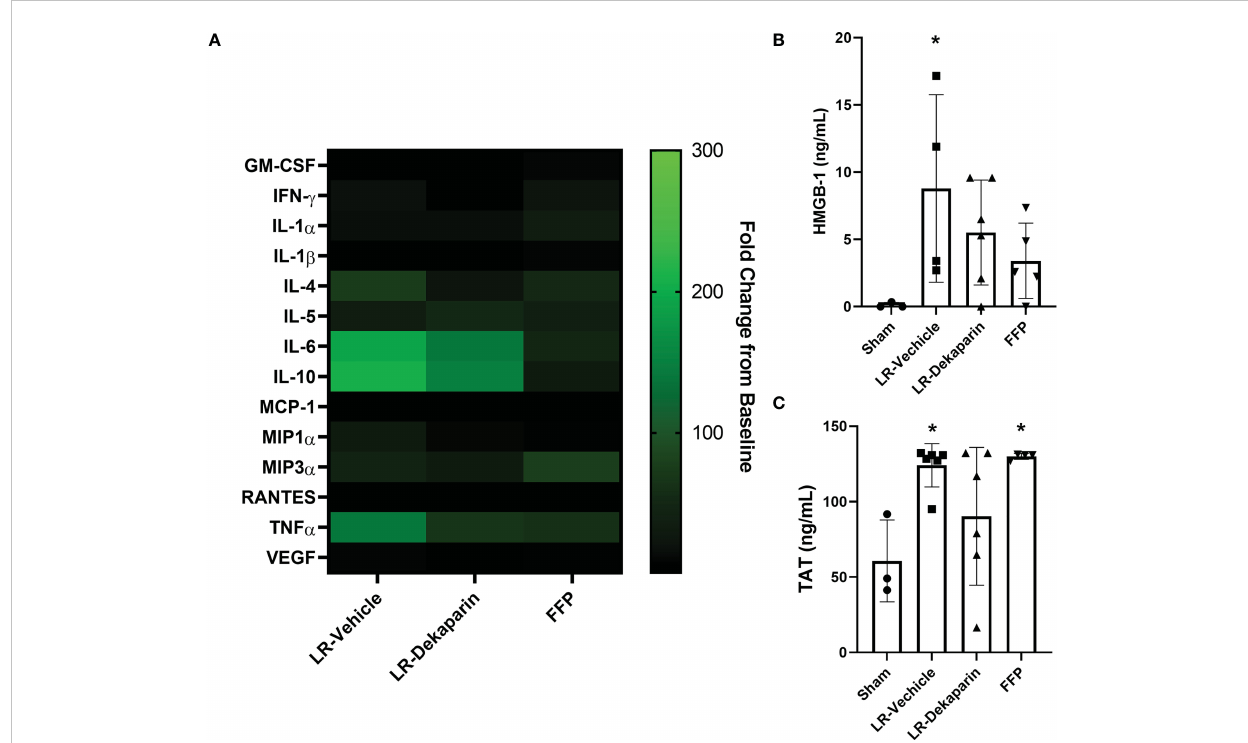
FIGURE 7 Dekaparin treatment decreases plasma levels of thromboin fl ammatory mediators after T/HS. (A) Cytokine and chemokines were quanti fi ed in the baseline and 3HR plasma sample by Bio-Plex Pro Rat Cytokine 23-Plex Assay. Analysis was restricted to N=4 per group due to assay cost. Markers that were undetectable were not included in the analysis. Data at 3HR were normalized to baseline values and expressed fold change over baseline in a heat map. (B) High mobility group box-1 (HMGB-1) and (C) thrombin-antithrombin (TAT) complex levels were measured in 3HR plasma samples by enzyme-linked immunosorbent assay (ELISA). For HMGB-1 ELISA: N=3 Sham, N=4 LR-vehicle, N=6 LR-Dekaparin, N=5 Sham. For TAT ELISA: N=3 Sham, N=6 LR-vehicle, N=6 LR-Dekaparin, N=4 FFP. Data are expressed as mean with standard deviation. * denotes p<0.05 compared to sham. LR=Lactated Ringer's; FFP=fresh frozen plasma; T/HS, trauma and hemorrhagic shock; 3HR, 3 hours after resuscitation; IL, interleukin; GM- CSF, granulocyte-macrophage colony-stimulating factor; IFN, interferon; MCP-1, monocyte chemoattractant protein-1; MIP, macrophage in fl ammatory protein; RANTES, regulated upon activation, normal T cell expressed and secreted; TNF, tumor necrosis factor; VEGF, vascular endothelial growth